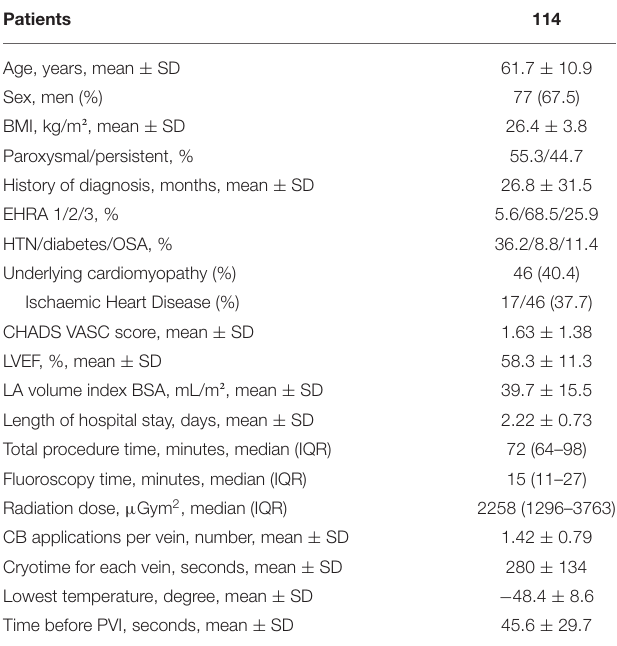
TABLE 1 | Baseline patients